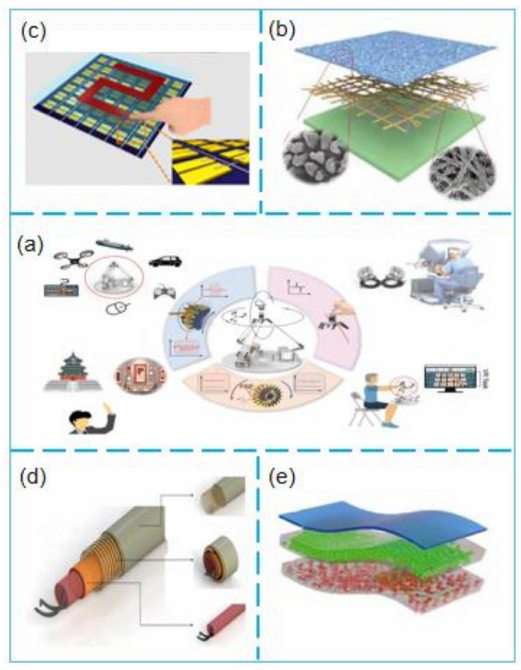
Figure 6. ( a ) Schematic illustration of the DT-HMI for diversified applications[117]; ( b ) Schematic illustration of the single-electrode ultrathin stretchable SI-TENG [118]; ( c ) Schematic illustration of the proposed touchpad showing the drawn pattern of number [119]; ( d ) Schematic illustration of